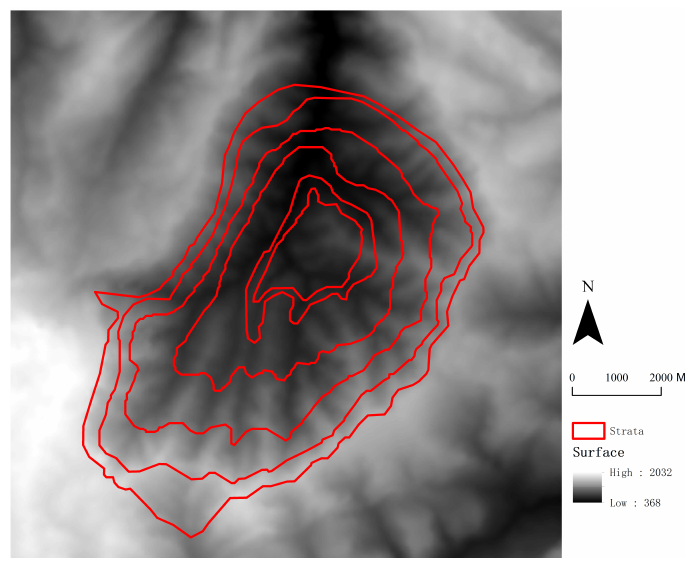
Figure 10. DEM of Wulongshan Dome and the projected vector stratum data in red.